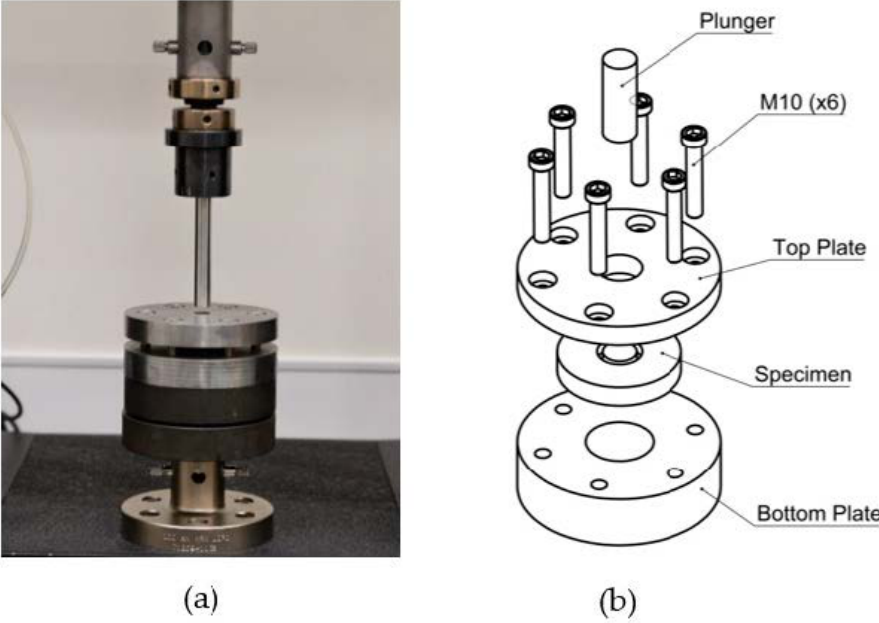
Figure 6. Test set-up for punch-out testing: ( a ) image of test set-up and ( b ) exploded diagram. For the cruciform and cylindrical punch-out tests, T-T tensile stress ( σ 33T ) was